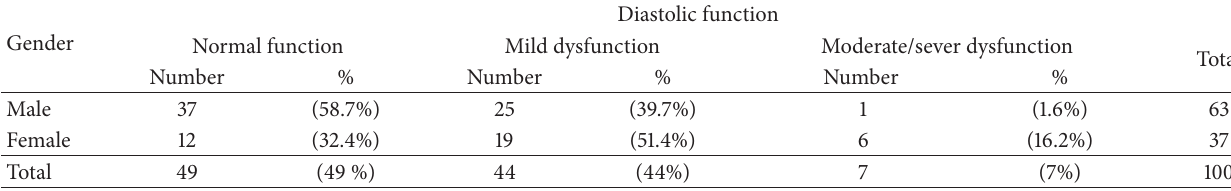
Table 4: Distribution of diastolic function by gender.